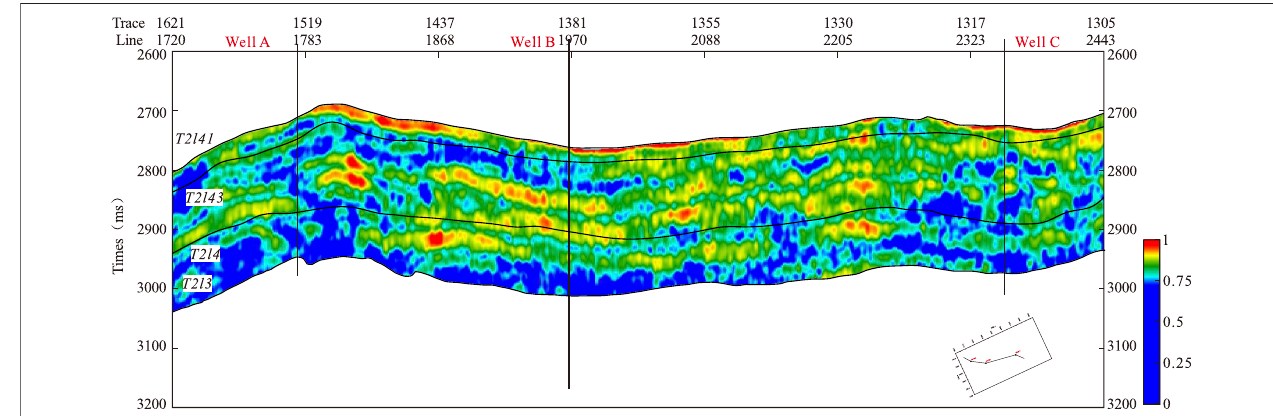
FIGURE 11 | Seismic-print analysis result.